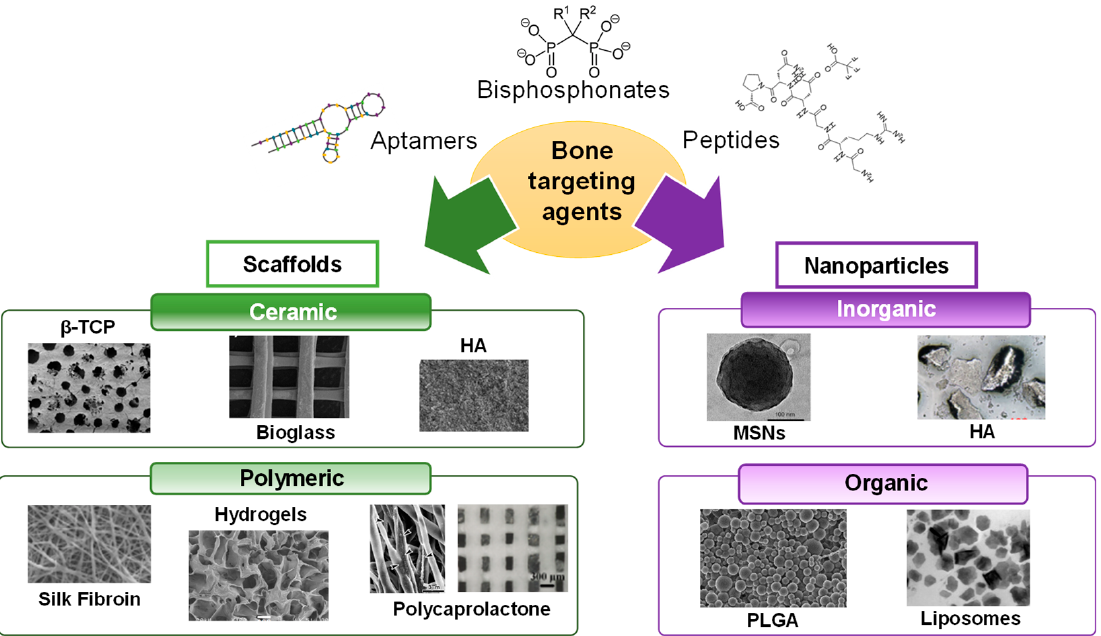
Figure 1. Summary of the different biomaterials that have been employed in the design of targeted systems for bone regeneration. Abbreviations: β -tricalcium phosphate ( β -TCP), hydroxyapatite (HA), mesoporous silica nanoparticles (MSNs), poly (lactic-co-glycolic acid) (PLGA).